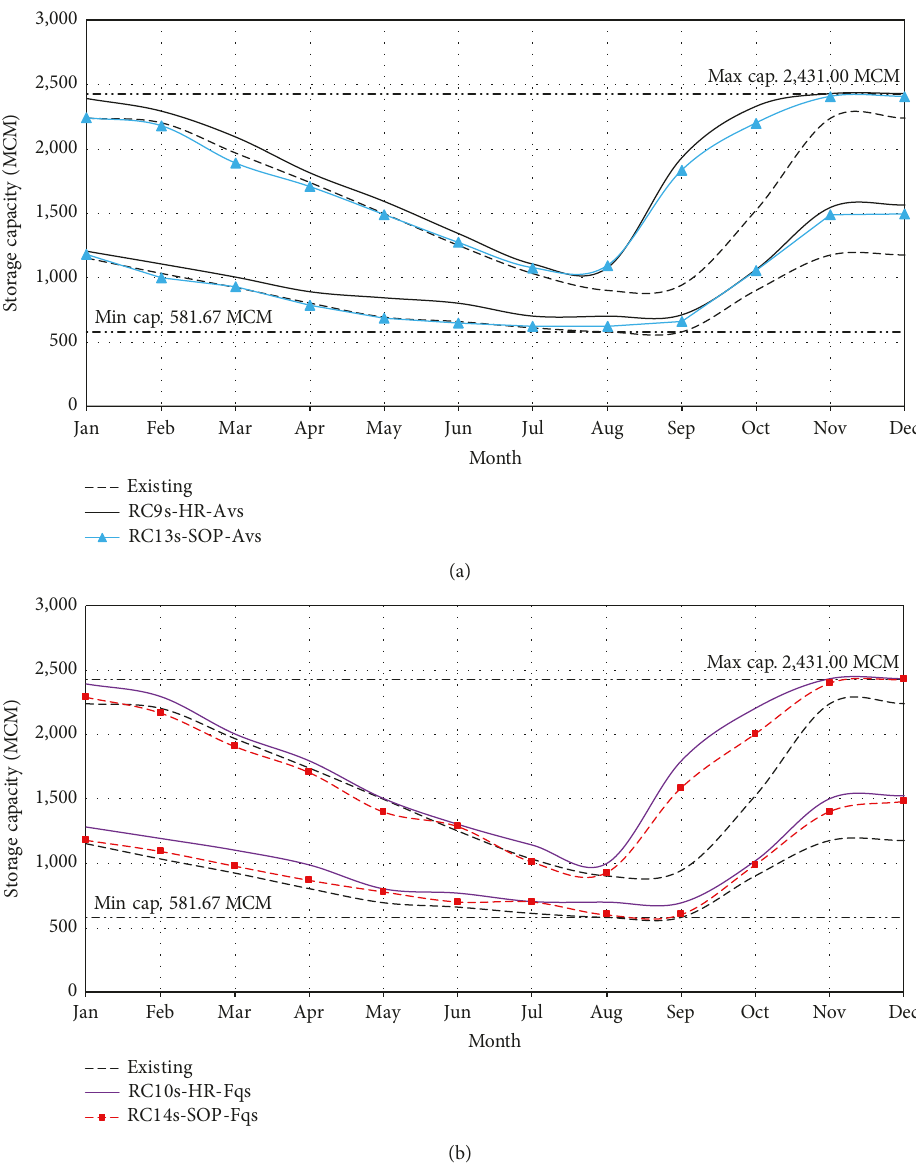
Figure 9: Optimal rule curves of the Ubolratana reservoir considering sedimentation with objective functions of (a) the minimal average water shortage per year and (b) the minimal frequency of water